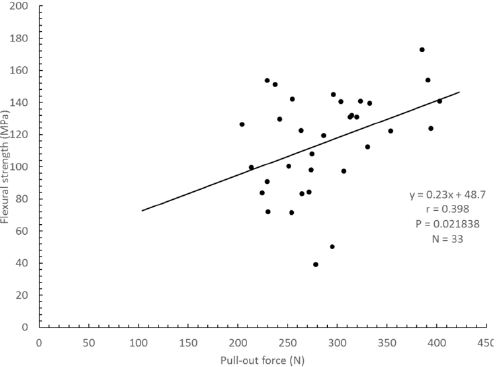
Figure 3. Relationship between flexural strength and pull-out force (r = 0.398, p = 0.0218, n = 33).